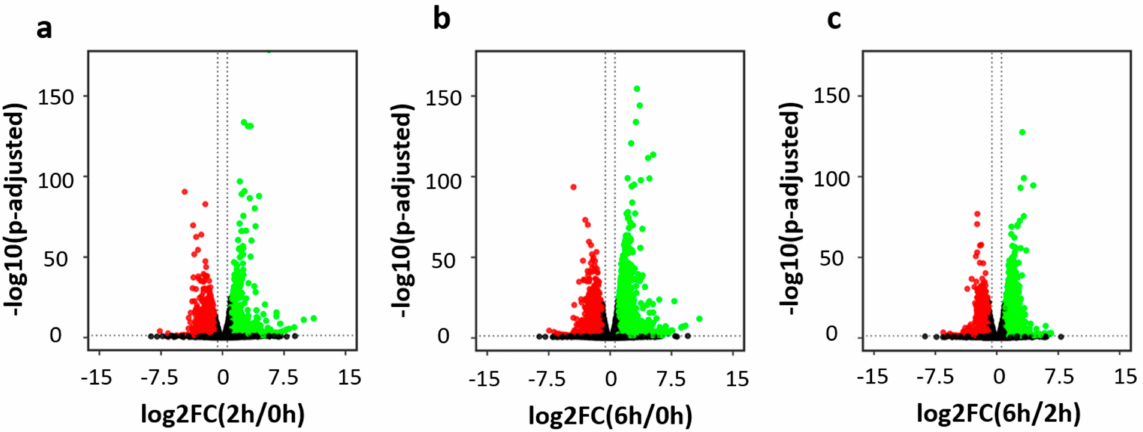
Figure 1. Experimental design. ( a ) Schematic representation of the experimental design. ( b ) E16.5 mouse cortical neurons were cultured in vitro for 7 days and double stained with the neuronal marker Tuj1 (green) and glial marker GFAP (red). Nuclei were counterstained with DAPI (blue). Scale bar: 50 µ m.